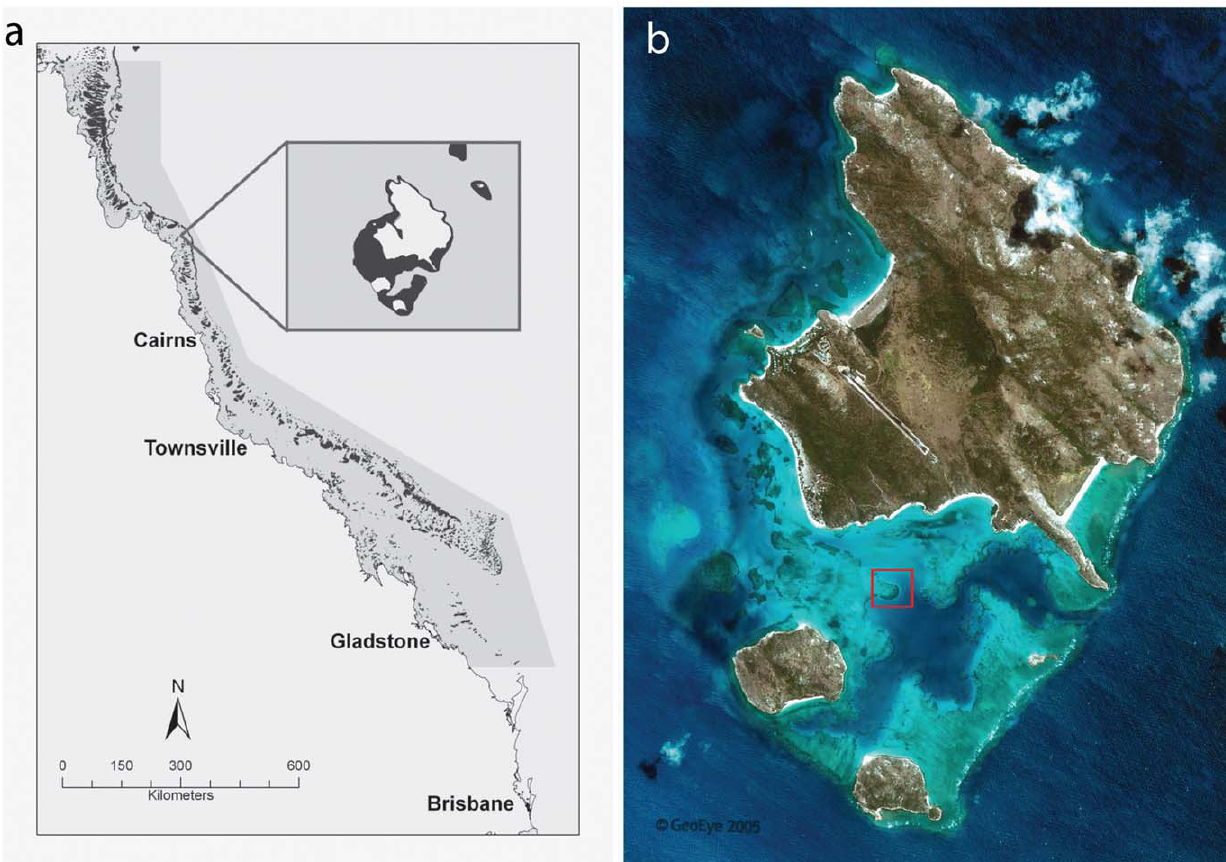
Figure 1. The collection site of Amakusaplanaacroporae. (a) Map of the Northern Great Barrier Reef, Australia with inset of Lizard Island. (b) Photo of Lizard Island with collection site (red square) of Amakusaplana acroporae from its host coral Acropora valida. Photo credit ‘‘GeoEye satellite image’’.